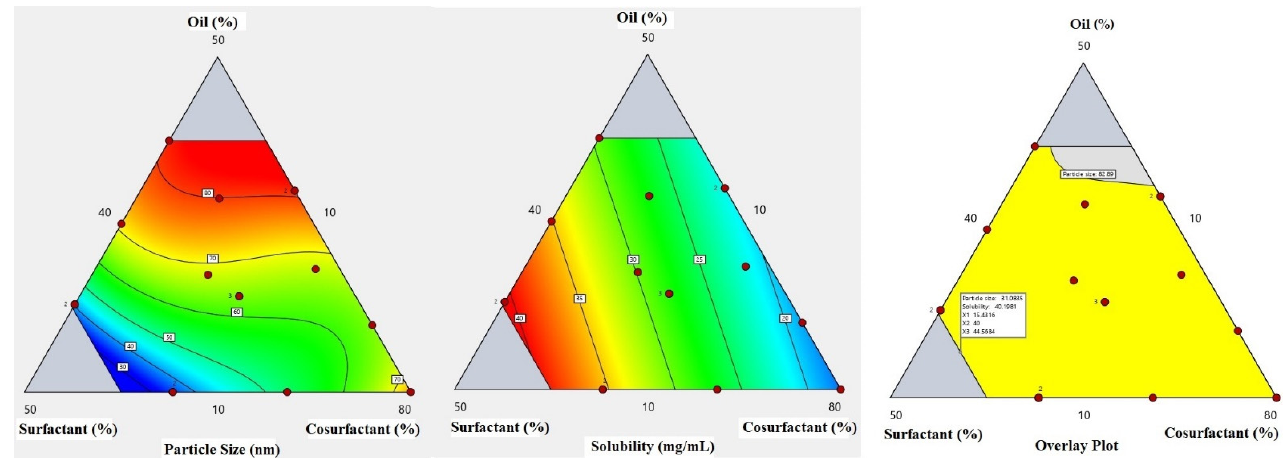
Figure 2. Contours for the particle size and drug solubility and overlay plot for the effect of the studied factors on particle size and solubility.